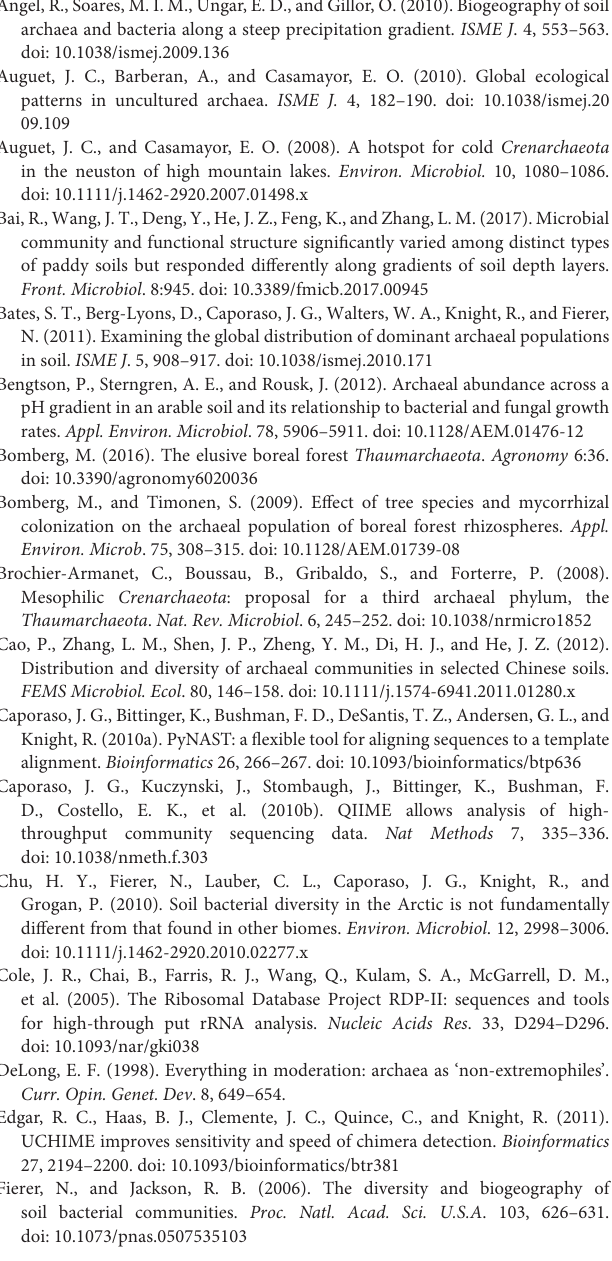
Table S2 | Relative abundance (%) of archaeal community at phylum, order and genus levels across all soil samples. Table S3 | Relative abundance, taxonomy information and represented sequence of OTUs observed in the black soils. The bold OTUs are the most abundant OTU in the black soils. Table S4 | The closest relative of each OTU observed in the black soils. Table S5 | The correlation coefficients (r) and significance levels (P) of pairwise 581 correlation between NMDS scores and soil total C content, and soil pH value. Values 582 in bold indicate significant correlations (P <